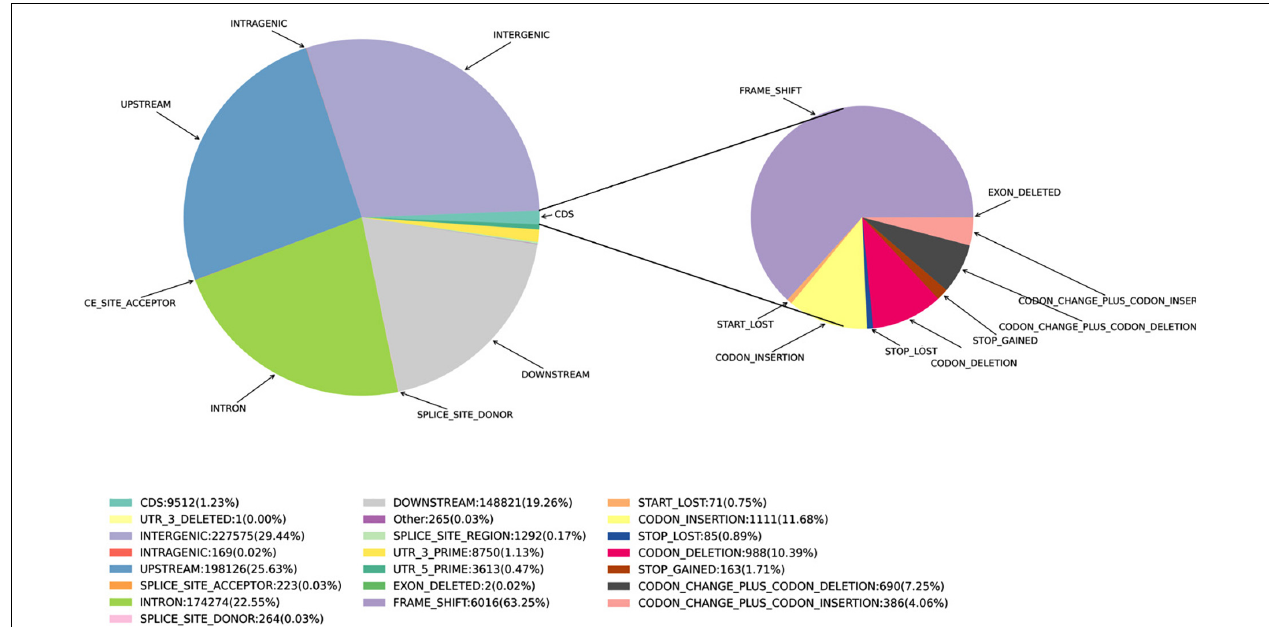
FIGURE 3 | Proportions of the various types of InDels in the Munake cultivar and the reference genome of V. vinifera .